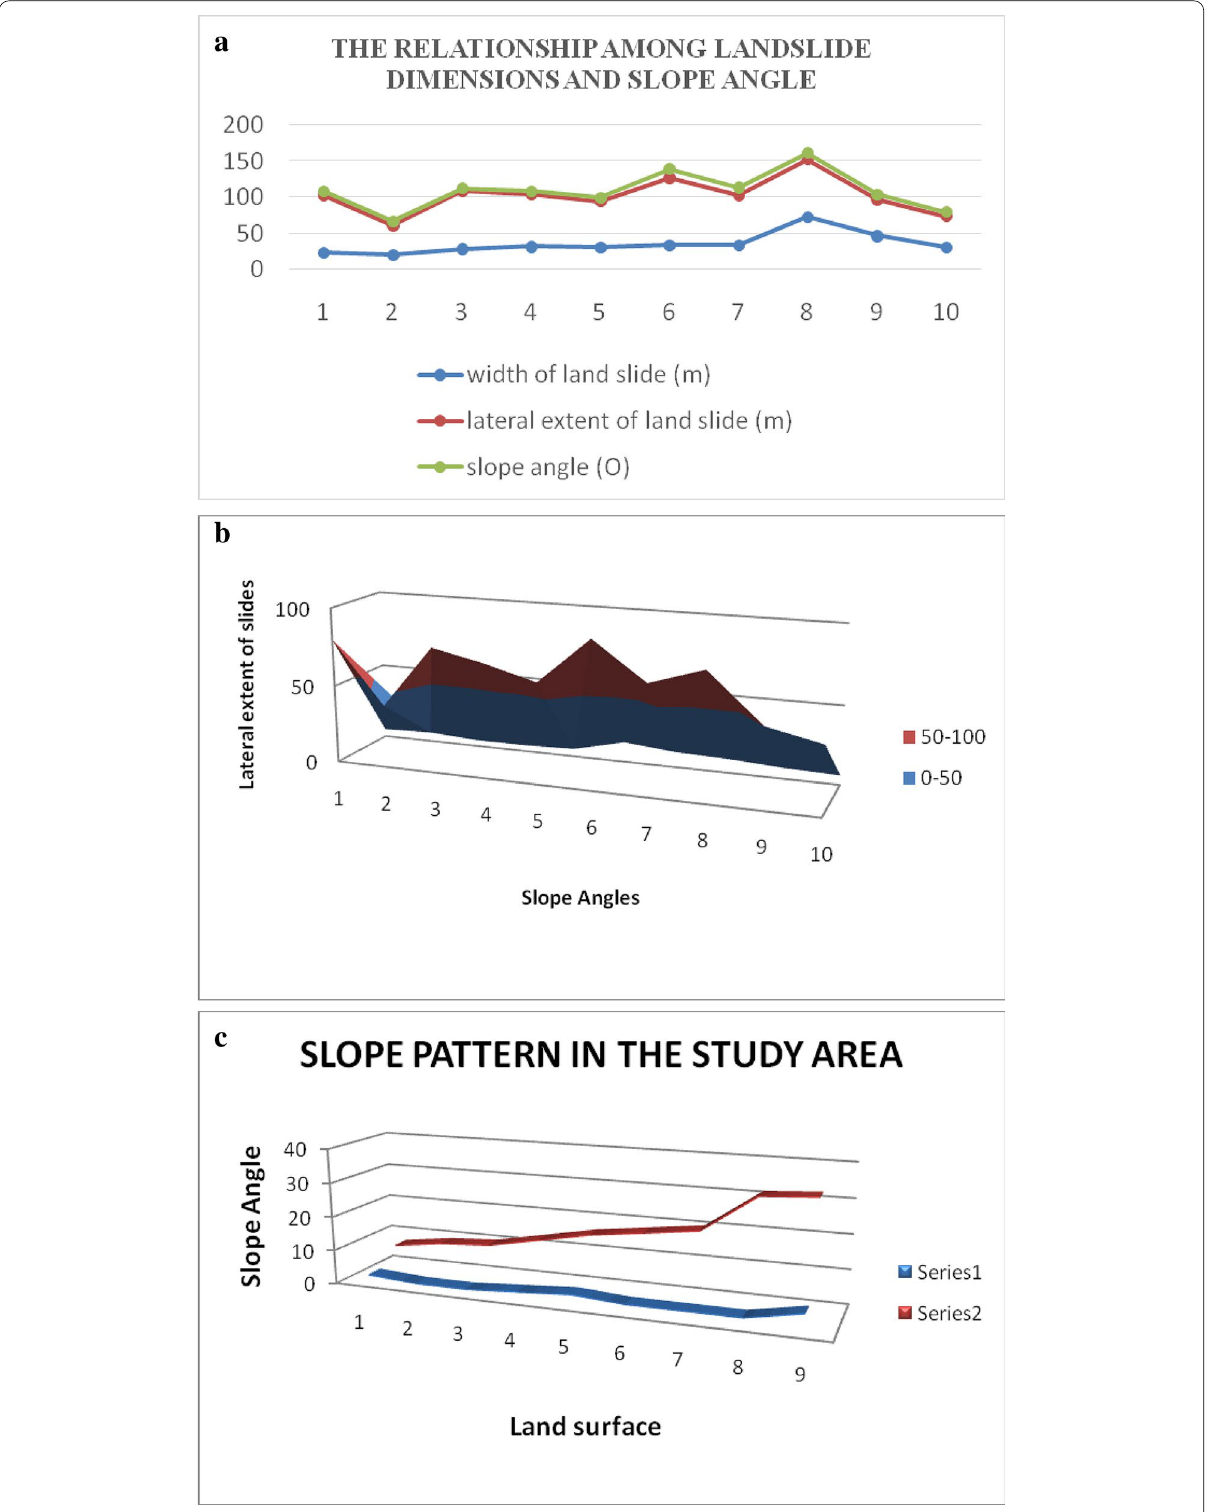
Fig. 5 a Plot of dimensions of landslides (m) against slope angles of the landslide. b 3D surface view of lateral angles versus slope angles of the landslide in the study area. c Slope pattern of the sliding in the study